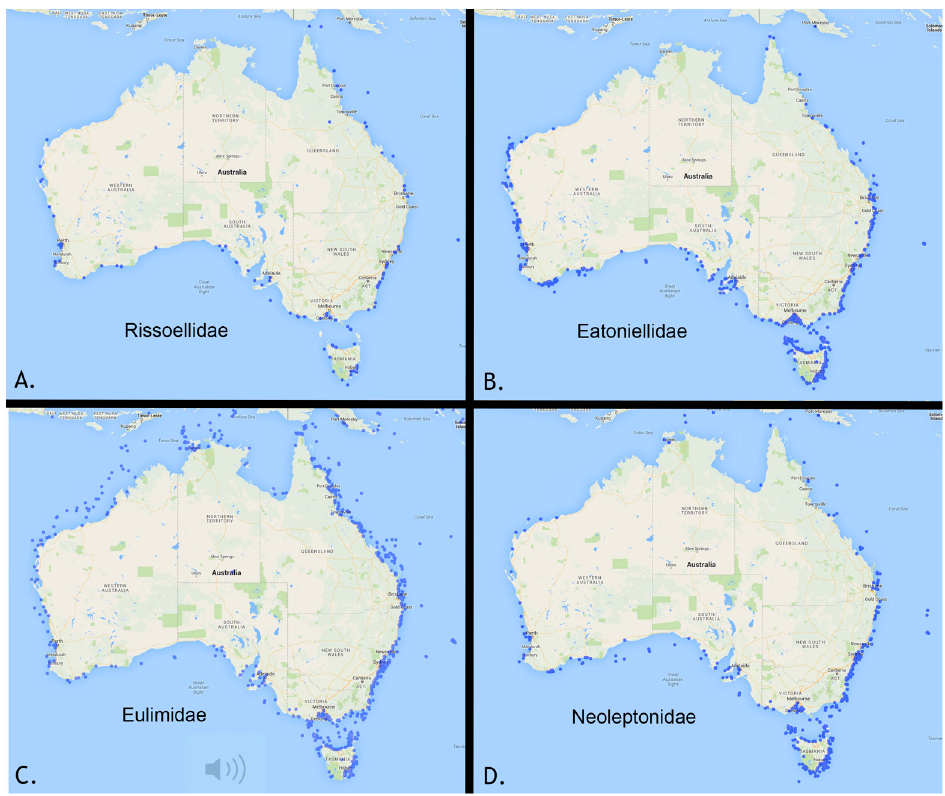
Figure 6. Regional biases for micromolluscs in Australia. An east coast bias is apparent in some groups (e.g., ( C ) Eulimidae; and ( D ) Neoleptonidae) while a southern bias (e.g., ( B ) Eatoniellidae) typifies the trend in others. Some groups have received little attention Australia-wide (e.g., ( A ) Rissoellidae). The highly diverse tropical reefs have overall received less attention than temperate ecosystems. Each dot represents an identified lot in a collection in Australia [14].